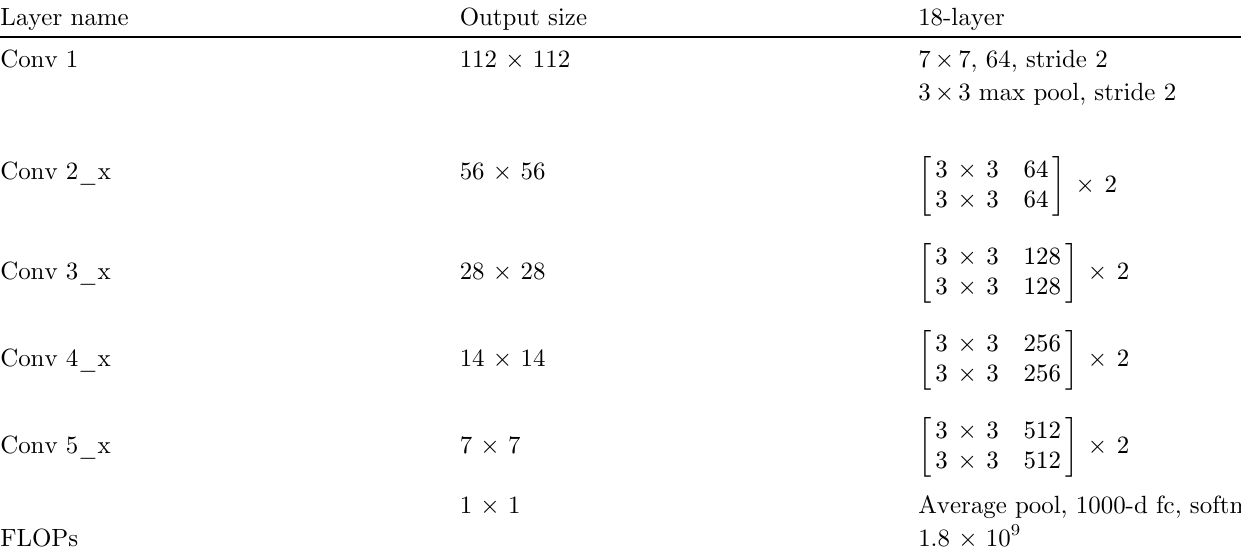
Table 2. ResNet18 network structure diagram.